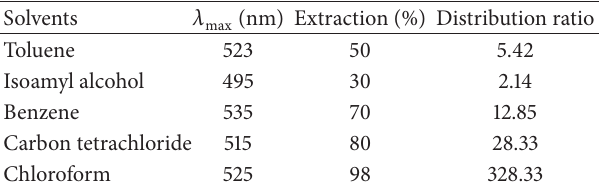
Table 1: Influence of solvents on extraction (%) of Th(IV). Solvents